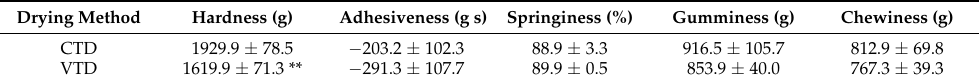
Table 8. Textural features of cooked